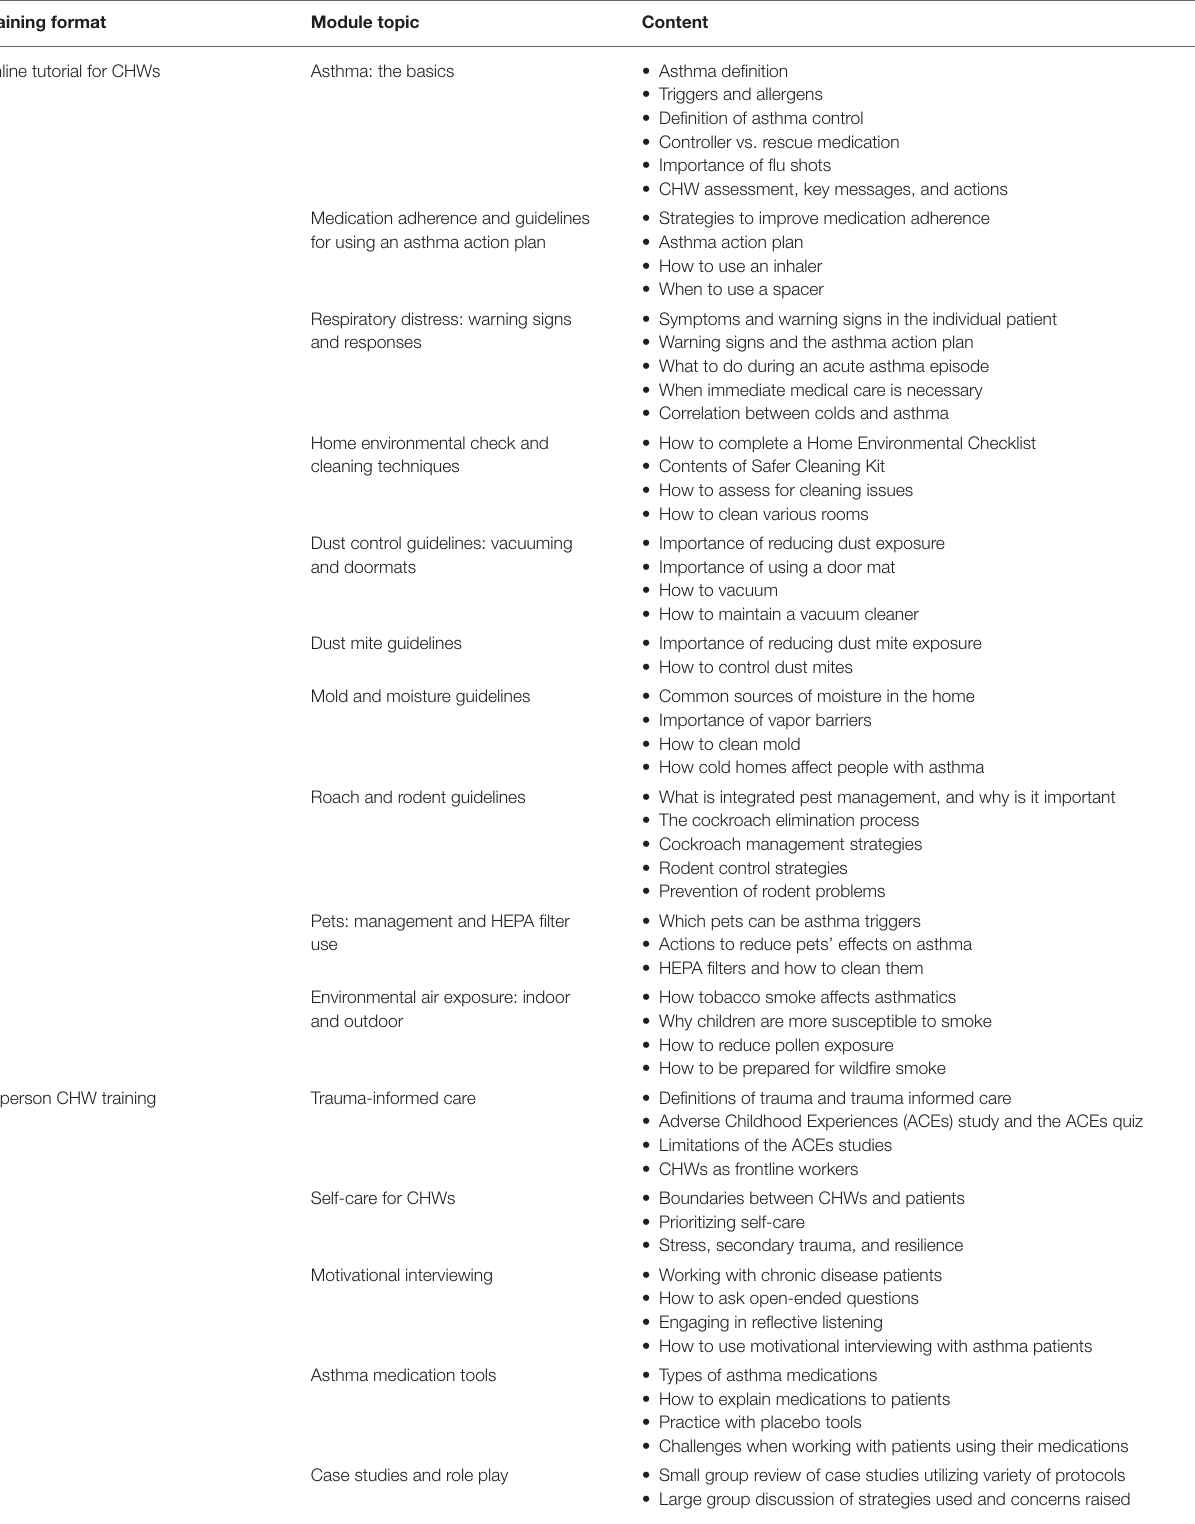
TABLE 2 | Training